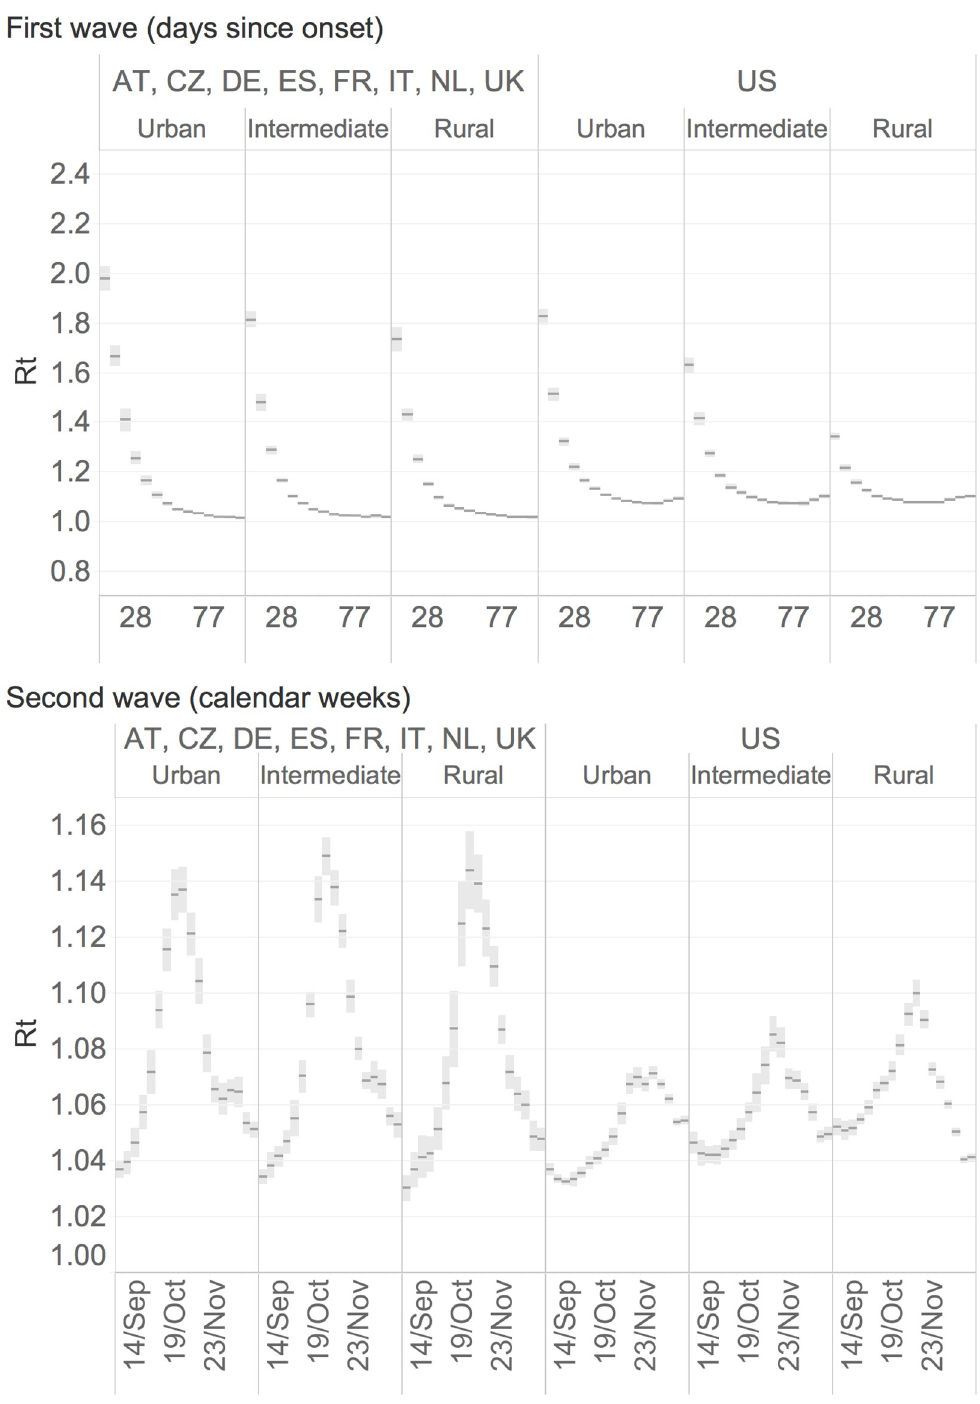
Fig 2. Median Rt values across European regions and US counties by rural-urban typology and sliding temporal windows. The upper part presents the median Rt values for days from the first recorded case in each region during the first wave. The lower part represents the median Rt values for calendar weeks during the second